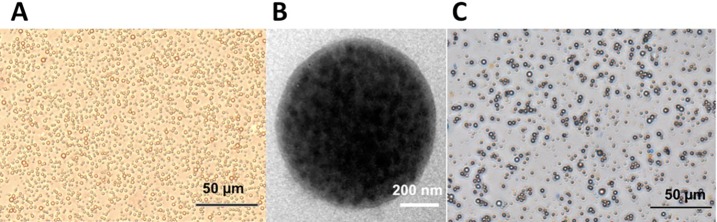
Characterization of PLGA/IO MPs.(A) Photomicrograph showed uniform size and even distribution instantly after preparation. (B) TEM image showed a spherical morphology with IO NPs encapsulated in the core. (C) Photomicrograph of PLGA/IO MPs after being stored for a month demonstrated no obvious aggregation or agglomeration.